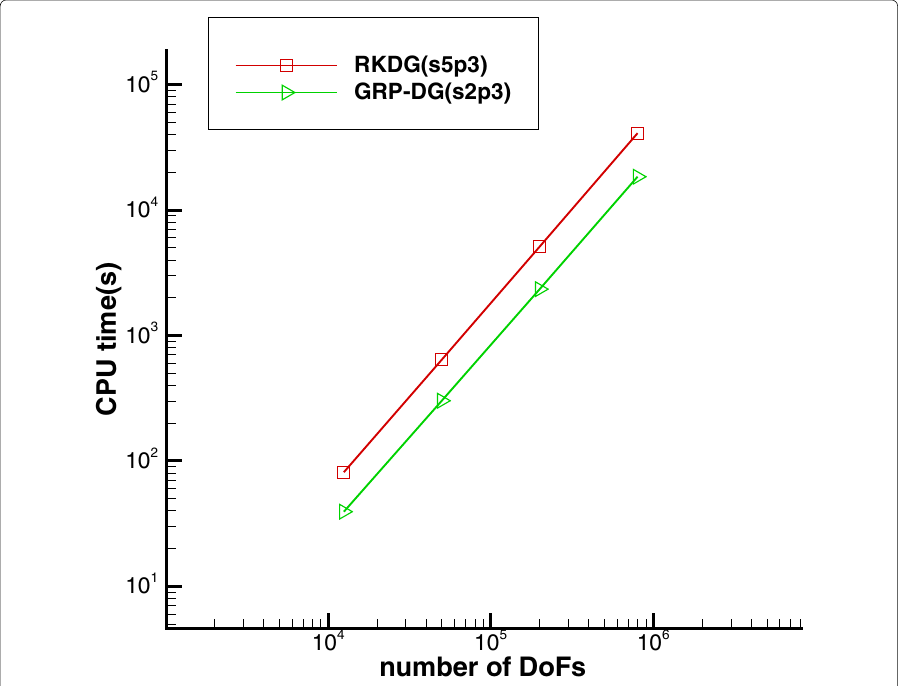
Fig. 6 Comparison of CPU time(s) between RKDG( s 5 p 3 ) method and GRP-DG( s 2 p 3 ) method for the shock vortex interaction